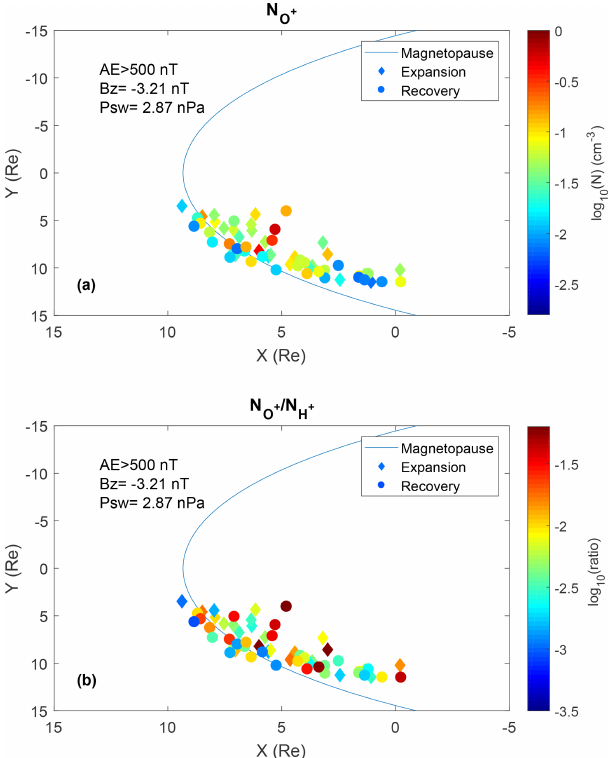
Figure 3. Maps of 57 events of energetic O + at the duskside mag- netopause during intense substorms with an AE index larger than 500nT in the XY GSM plane. The O + density and the density ratio of O + / H + are shown by the color signatures at the corresponding magnetopause locations in (a) and (b) , respectively. The blue curve line represents the nominal magnetopause. The diamond and circle represent the event at the magnetopause during the intense substorm expansion phase and recovery phase,